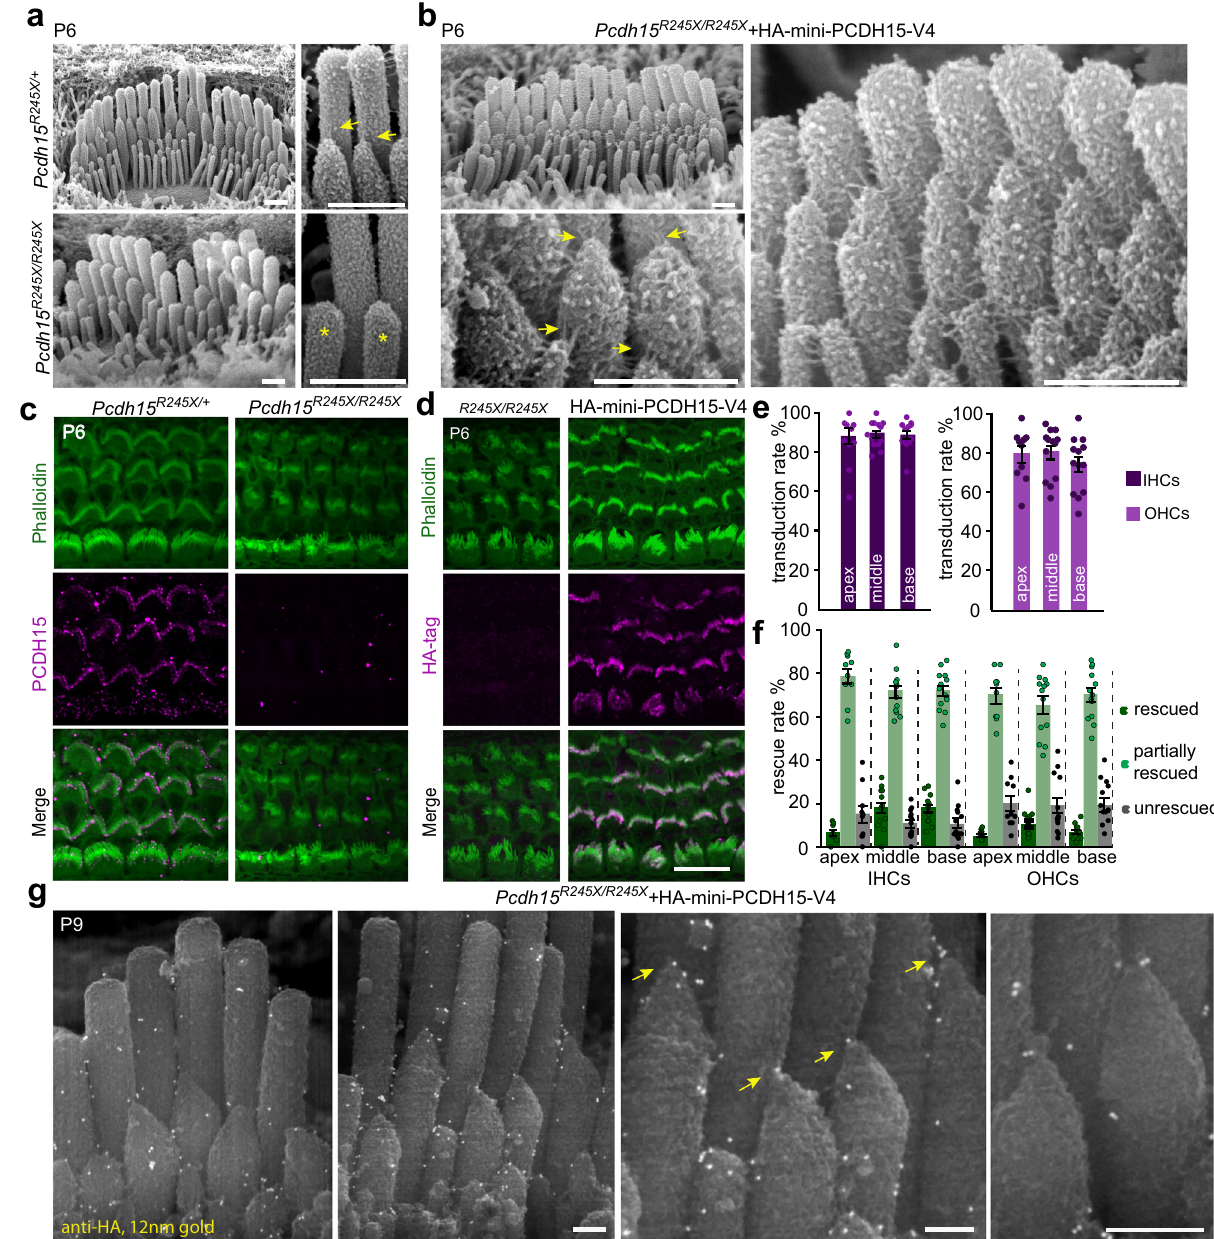
Fig. 7 | Delivery of AAV-HA-mini-PCDH15-V4 rescues stereocilia tip links in the R245X knockout mouse model. a Scanning electron micrographs of the organ of Cortifrom Pcdh15 R245X/+ hearingcontrolmiceatP6(upperpanel).Hairbundleshave normal morphology and tip links connect the tips of adjacent stereocilia (yellow arrows). Organ of Corti from Pcdh15 R245X/R245X homozygous null mice at P6 (lower panel). Bundles are severely disrupted, stereocilia are shortened, and no tip links are detected (yellow asterisk) although the lateral links are present. b Hair cells in Pcdh15 R245X/R245X homozygous knockout mice expressing HA-mini-PCDH15-V4. Bun- dle morphology was partially or fully restored. High magni fi cation images demonstrate the presence of tip links (yellow arrows) in rescued bundles at P6. c Representativeconfocalmicroscopyimagesofanti-PCDH15labeling(magenta)of organ of Corti along with actin staining (phalloidin, green) demonstrated normal bundle morphology and PCDH15 localization to the stereocilia tips in Pcdh15 R245X/+ controlmice(left).In Pcdh15 R245X/R245X knockoutmicethehairbundles wereseverely disorganized and no anti-PCDH15 labeling was detected (right). d Representative confocalmicroscopyimagesofthecochleashowinganti-HAstaining(magenta).No